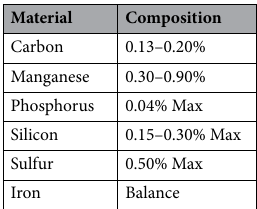
Table 3. The composition of the low carbon steel sample.